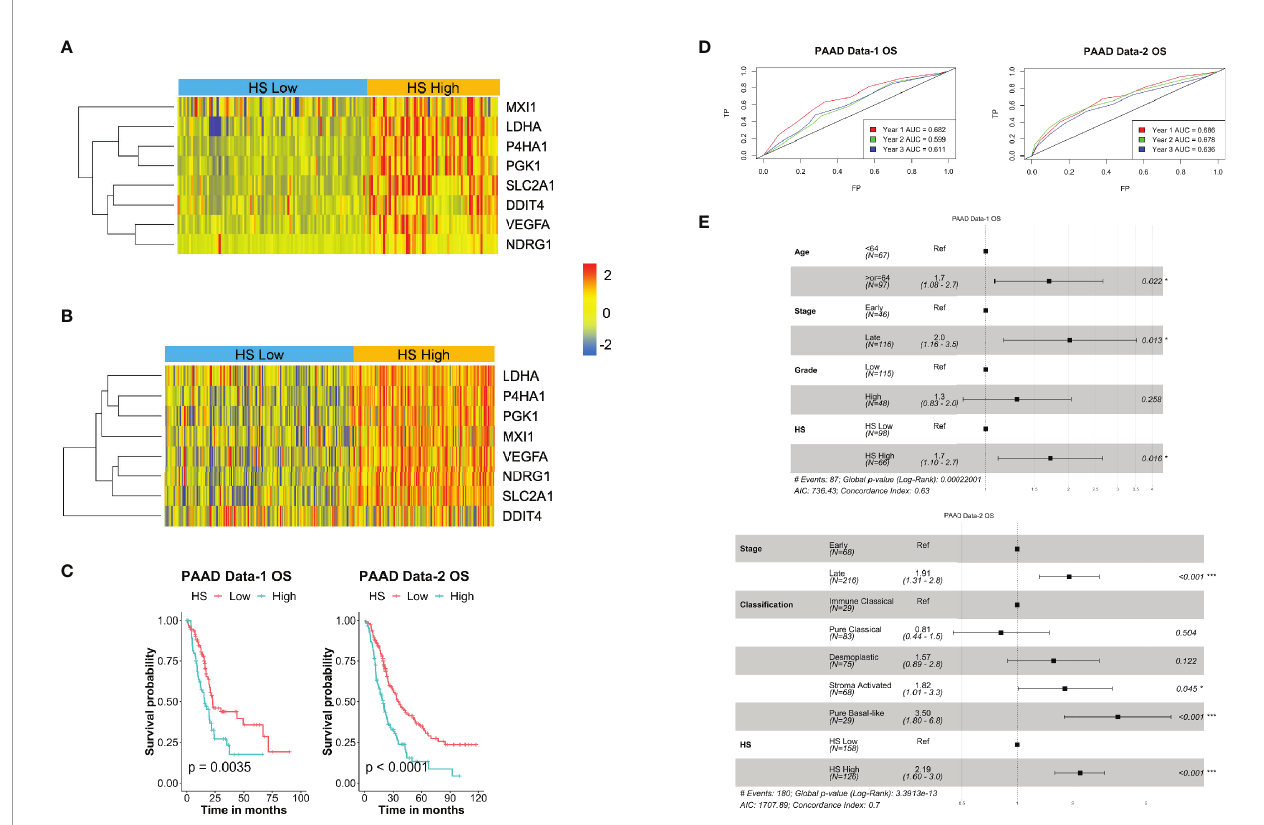
FIGURE 2 | Prognostic and predictive value of hypoxia signature in pancreatic cancer: Heatmaps of the expression levels of the eight genes in the signature in hypoxia score (HS) high (in orange) and HS low (in blue) tumors in PAAD Data-1 (A) and PAAD Data-2 (B) . (C) Kaplan-Meier survival plots with log-rank test, comparing the groups divided based on hypoxia score in PAAD Data-1 and PAAD Data-2. (D) ROC curves depicting the predictive ef fi ciency of the hypoxia signature on OS considering the 1-, 2-, and 3- years survival rates. (E) Multivariate COX PH forest plots showing hazard ratio of OS considering the 8-gene HS and other clinical covariates. P-value < 0.05 considered statistically signi fi cant; OS, overall survival; AUC, area under the curve; FP, false positive (1 - speci fi city); TP, true positive